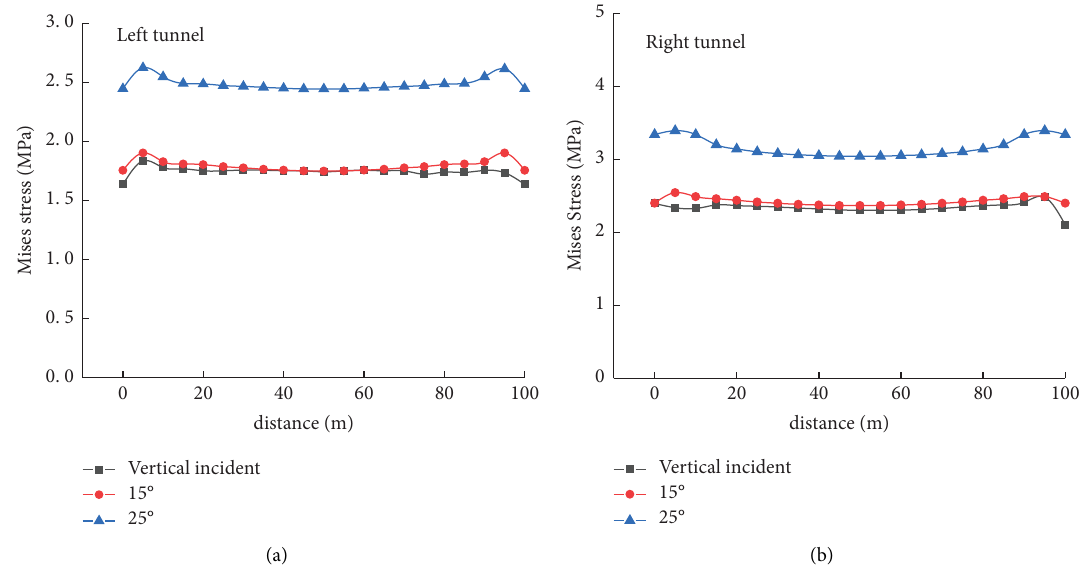
Figure 11: Distribution of peak Mises stress along the tunnel axis under diferent incident angles: (a) left tunnel Mises stress and (b) right tunnel Mises